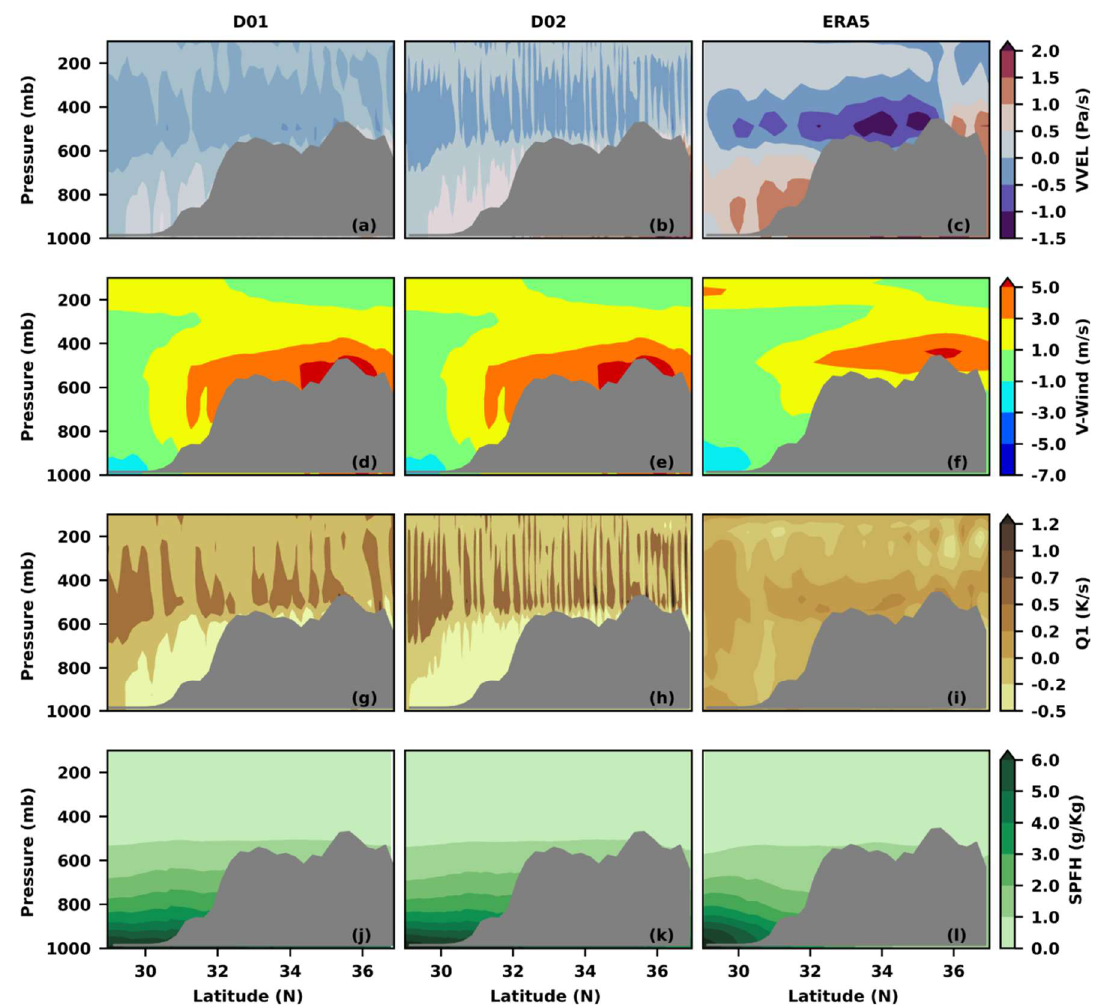
Figure 9. Latitudinal cross-section of vertical velocity observed in D 01 ( a ), D 02 ( b ), ERA5 ( c ); meridional component of wind observed in D 01 ( d ), D 02 ( e ), ERA5 ( f ); apparent heat source observed in D 01 ( g ), D 02 ( h ), ERA5 ( i ); specific humidity observed in D 01 ( j ), D 02 ( k ), ERA5 ( l ) along longitude 76.88° E.